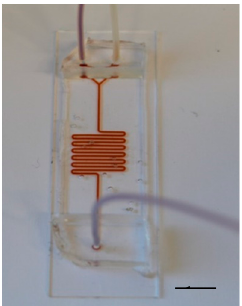
Figure 4. Meander shape microfluidic reservoir fabricated with